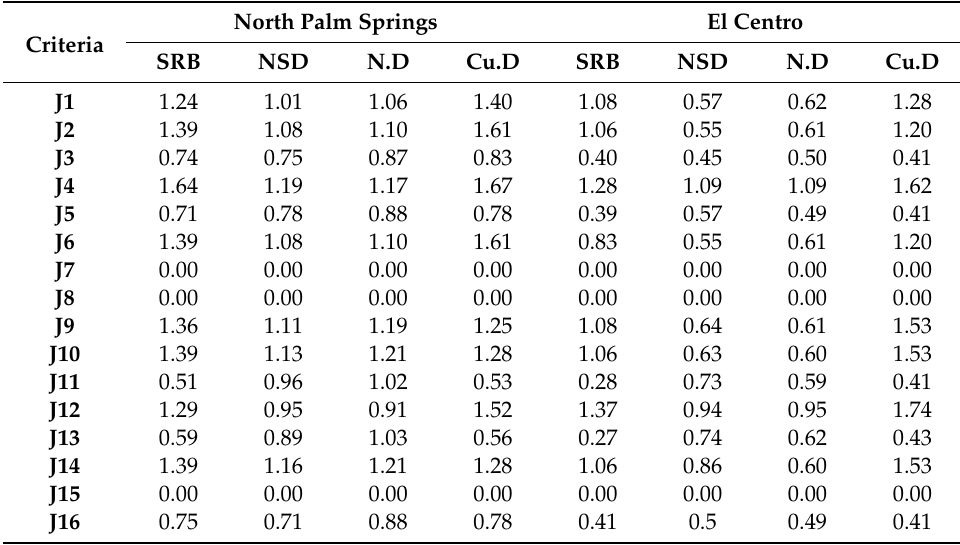
Table 6. Nonlinear dynamic analysis results of the benchmark bridge equipped with SMA-LRB isolators under far-field